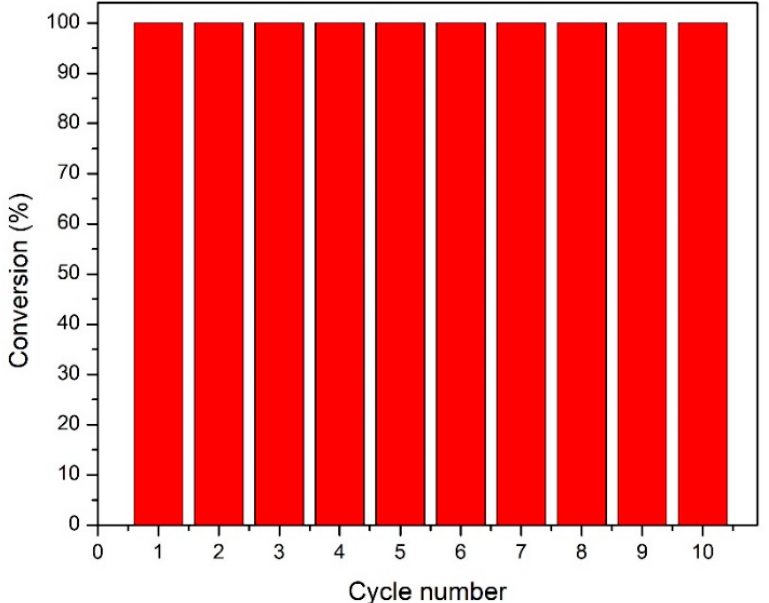
Figure 6. Recyclability of the Pd NPs /PEG 200 @PU microreactor in the hydrogenation reaction of styrene (reaction conditions: 0.2 mol% of Pd (substrate/Pd ratio = 500), 2.5 h, r.t., 100 psi of H 2 ).